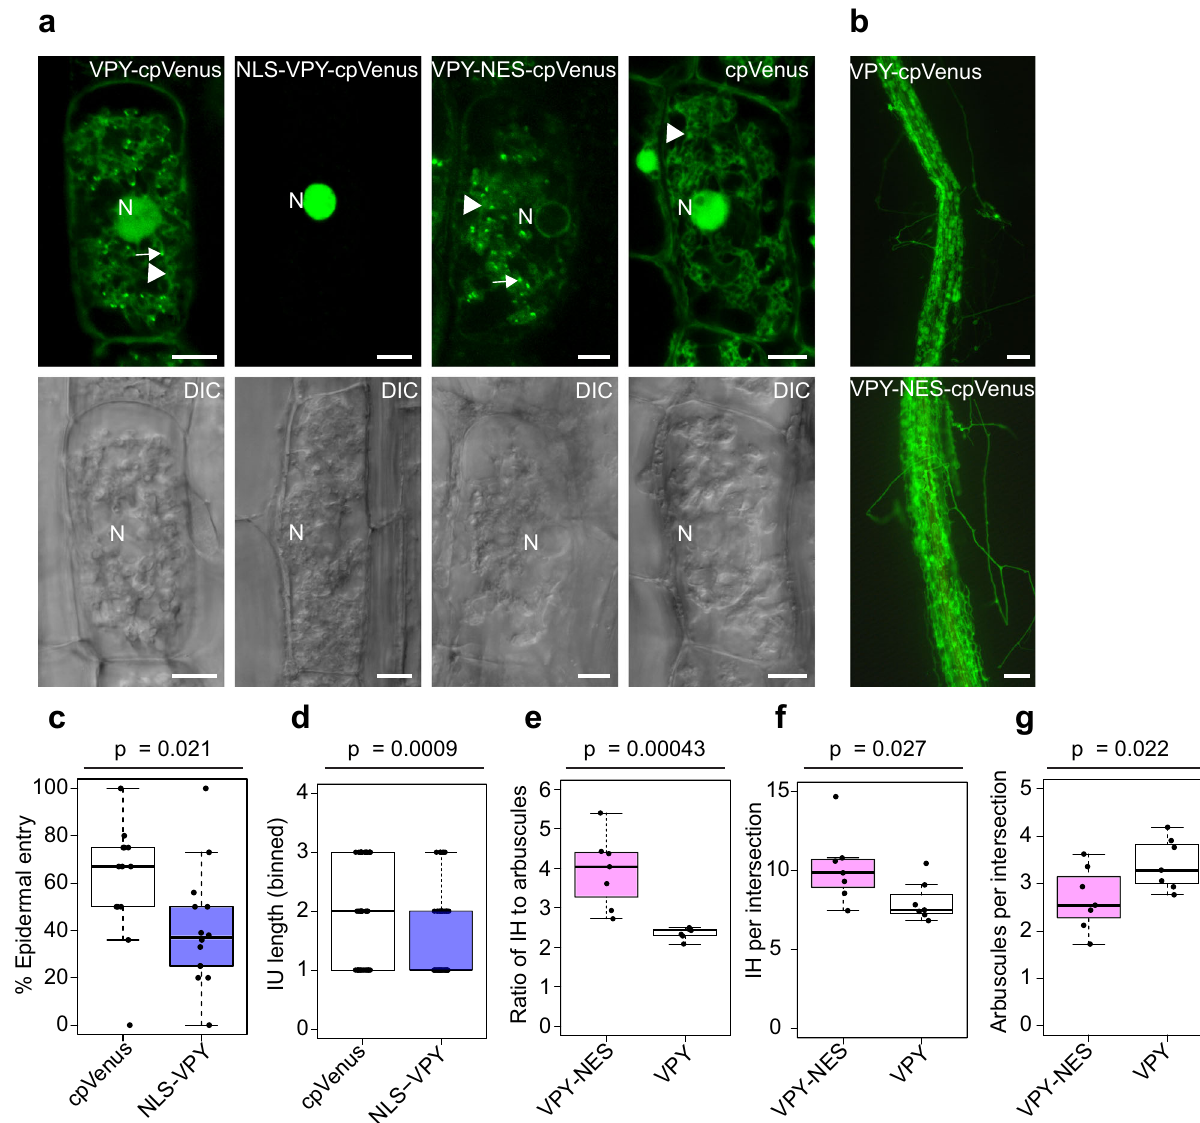
Fig. 4 | Effect of NLS-VPY and VPY-NES on vpy-4 . a Representative images of arbuscule-containing cells expressing VPY pro :VPY-cpVenus (VPY, n =28) , VPY pro :NLS-VPY-cpVenus (NLS-VPY, n =16), VPY pro :VPY-NES1-cpVenus (VPY-NES1, n =19),or VPY pro :cpVenus (cpVenus, n =15).NLS-VPYaccumulatesexclusivelyinthe nucleus, whereas VPY-NES1 is excluded from the nucleus. Scale bars are 10 μ m. Arrows, puncta, arrowheads, cytoplasmic signal, N, nucleus. Three transgenic plants were imaged per construct. b Representative epi fl uorescence images of vpy-4 WGA-AlexaFluor 488 stained roots complemented with VPY pro :VPY-cpVenus (VPY), or VPY pro :VPY-NES1-cpVenus (VPY-NES). Scale bars are 100 μ m. c The per- centage of successful epidermal entry by D. epigeae in vpy-4 roots transformed with